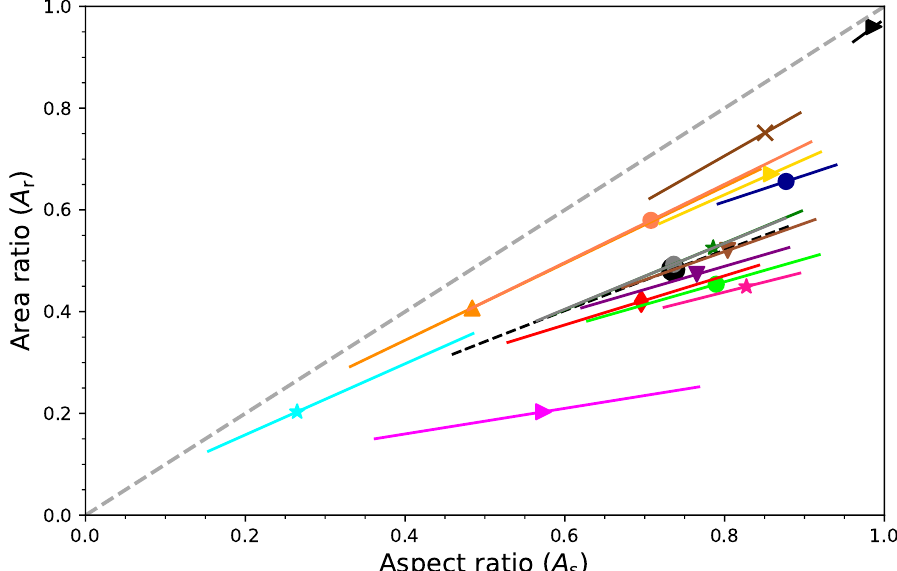
Figure 6. Area ratio versus aspect ratio ( A r vs. A s ) relationships for each shape group (solid lines) and for all data regardless of shape (black dashed lines) are shown. Fits for the A r vs. A s relationship are given by Equation (5). The median A s is represented as a single point on each line. The lengths of the fit lines are defined by the percentiles 15.9% and 84.1% of A s . For comparison, spherical particles are shown ( A r = A s ) as dashed gray line. For a legend, see Figure 4. Data are shown in Table 9.